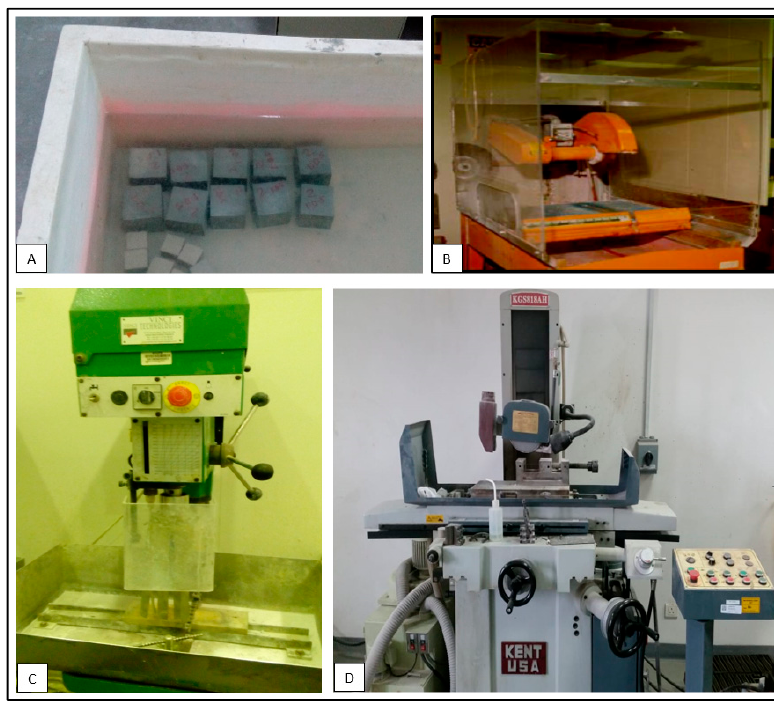
Figure 1. Sample preparation phases of cement mortar ( A ) Curing, ( B ) Cutting, ( C ) Coring, ( D ) End face grinding.